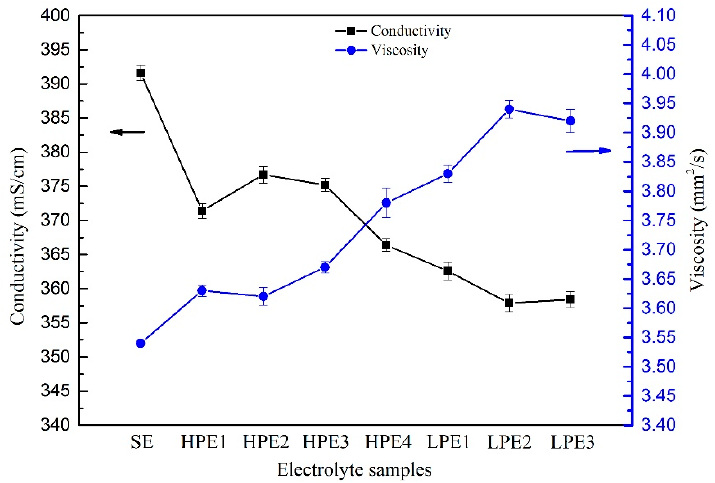
Figure 3. The conductivity and viscosity of electrolytes prepared with different grades of V 2 O 5 raw material.